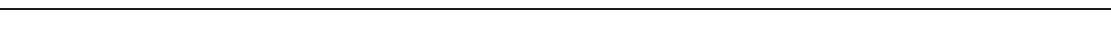
Fig. 3 TAB cells modulate melanoma cells to express FGFR-3 and its ligand FGF-2 for tumor stroma-tumor cell cross-talk. a WM3749 co-cultured (72h) with TAB cells ( red bar ) show increased FGFR-3 mRNA expression when compared with tumors only ( open bar ) or co-cultured with NB cells ( blue bar ). b Lysates obtained from pools of melanomas co-cultured (72 – 120h) with NB- or TAB cells were probed in western blot with anti-FGFR-3 antibody ( left panel ), results expressed as relative intensity after β -actin normalization ( right panel ). c Melanoma cells co-cultured with TAB cells (72h) show increased phospho-FGFR-3 expression ( right panel ; immuno fl uorescence assays) when compared with melanoma cells alone ( left panel ) or melanoma cells co-cultured with NB cells ( middle panel ), scale bars : 40 μ m, images captured by Nikon inverted microscope. d Melanoma cells co-cultured with TAB cells ( red bar ) show increased FGF-2 mRNA expression when compared with melanoma cells alone ( open bar ) or melanoma cells co-cultured with NB cells ( blue bar ). e 451Lu and WM989treated with IGF-1 (25ng/ml/daily for 5 days; red bar ) show increased FGFR-3 expression when compared with untreated controls ( blue bar ), fl ow cytometry results expressed as net % expression of control antibody. IGF-1 treated melanoma cells ( red bars ) show higher expression of FGFR-3 compared with untreated cells ( blue bars ). Bar represents mean+SD of replicate samples. f NB cells treated with FGF-2 (10 ng/ml/daily for 4 days; red bar ) show high IGF-1mRNA expression relative to untreated NB cells ( blue bar ). g 451Lu and WM989 co-cultured (72h) with TAB cells in the presence of an anti-IGF-1 neutralizing antibody (10 μ g/ ml) show decreased FGFR-3mRNA expression in tumor cells ( blue bar ) when compared with controls ( red bar ). h TAB cells co-cultured (72h) with 451Lu and WM989 in the presence of an anti-FGF-2 neutralizing antibody (1 μ g/ml) show decreased IGF-1mRNA expression in B cells ( blue bar ) when compared with controls ( red bar ).Experiments in a , d and f – h were performed using qPCR. In Figures a , d – h , bars represent mean+SE of duplicate samples and are representative of at least two independent experiments. i Summary of cross-talk between melanoma and B cells: FGF-2 is constitutively expressed by